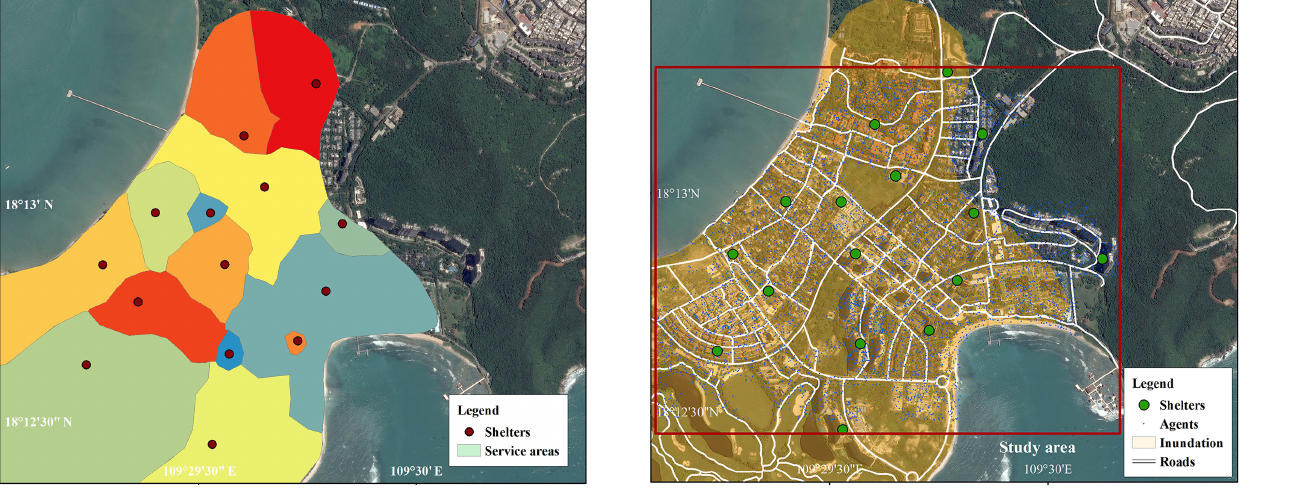
Figure 9. Service areas of vertical shelters for the Luhuitou Com- munity.